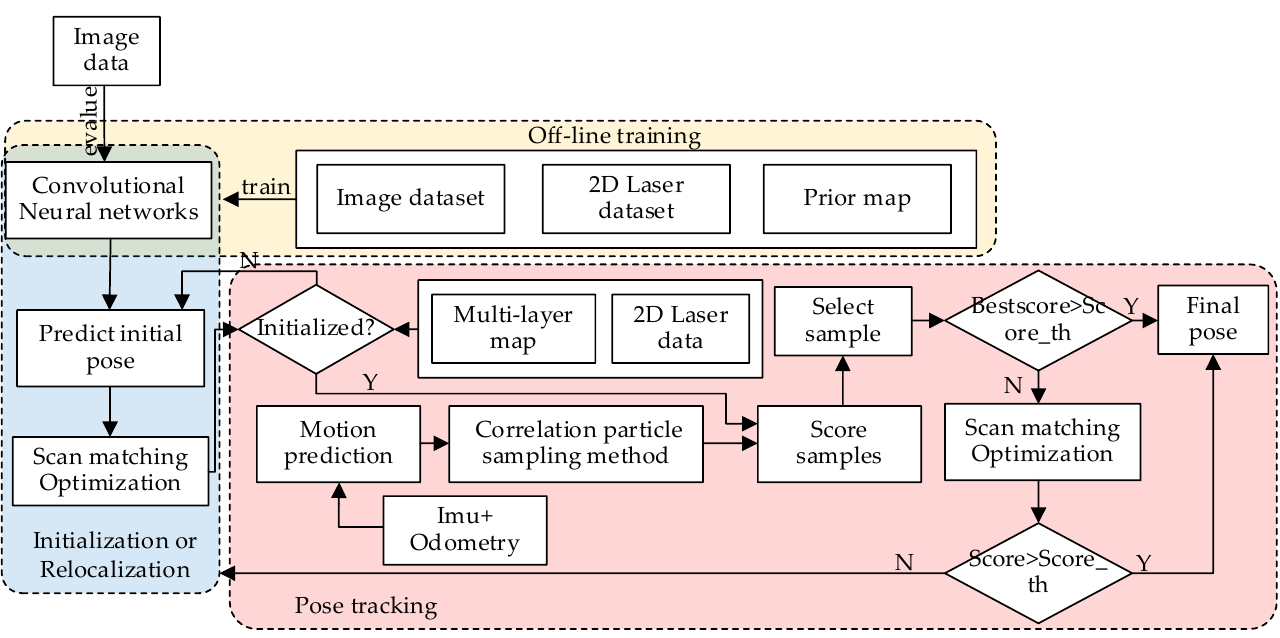
Figure 1. System framework.